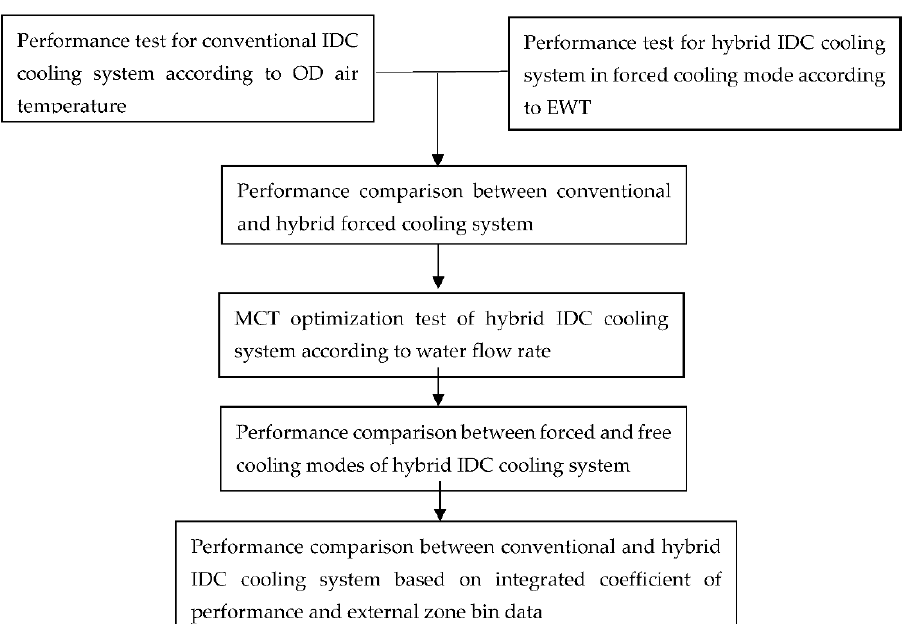
Figure 3. Flow chart of the experimental procedure.